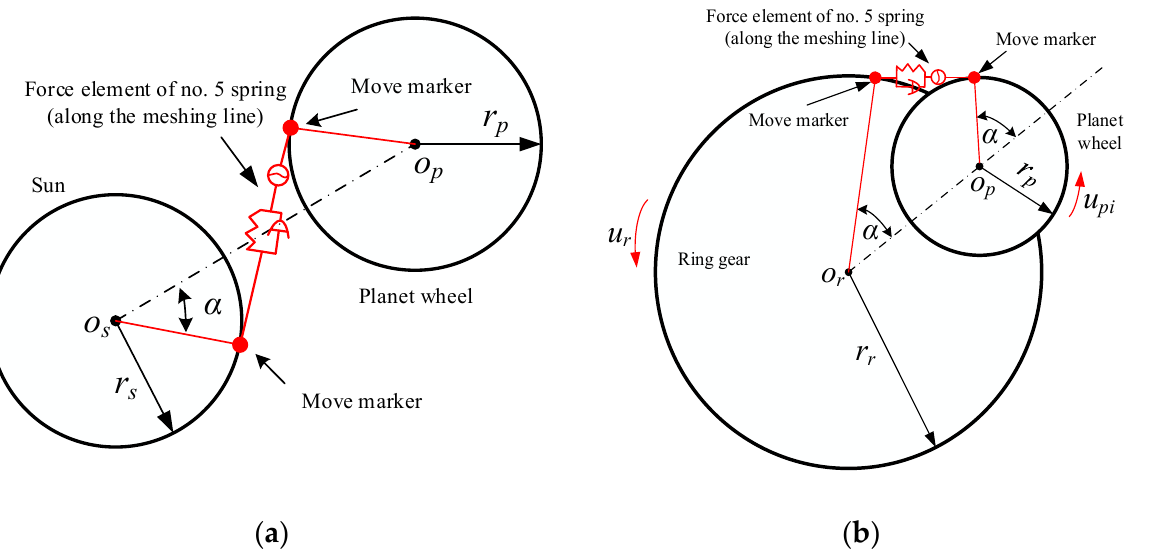
Figure 2. SIMPACK spring unit and move marker point setting diagram. ( a ) Setting between sun and planet wheel and ( b ) setting between ring gear and planet wheel.